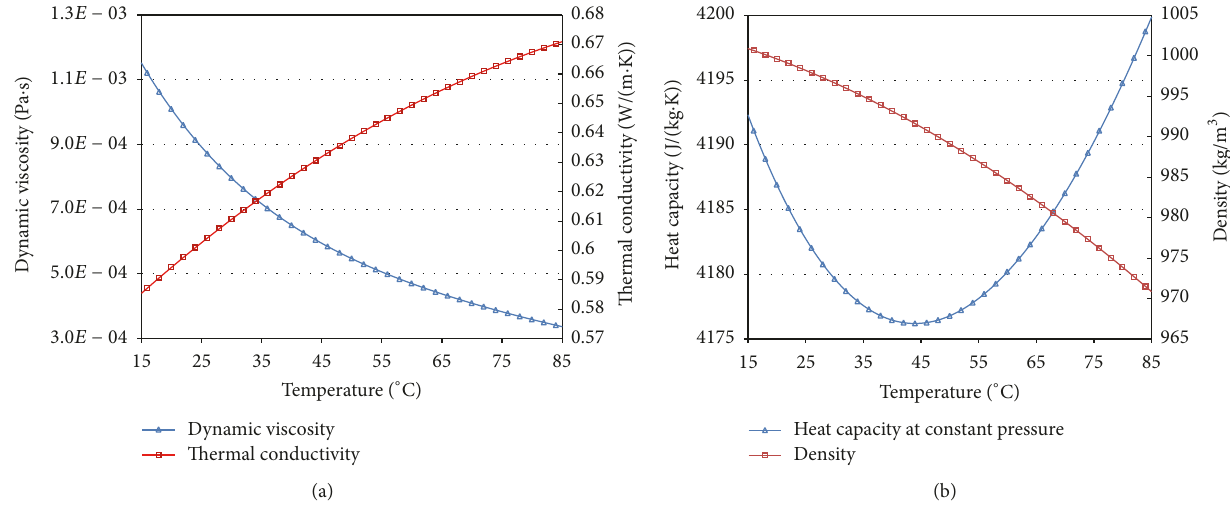
Figure 12: Properties of the fluid as a function of temperature. (a) Dynamic viscosity (blue curve) and thermal conductivity (red curve). (b) Heat capacity at constant pressure (blue curve) and density (red